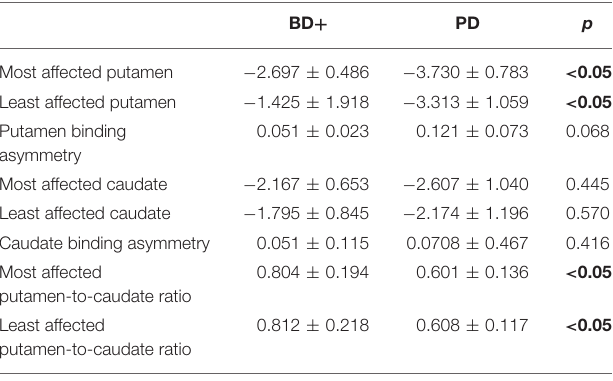
TABLE 3 | Comparisons of DaT binding values ( z scores) between BD patients with abnormal DaTSCAN (BD + ) and 12 age-matched PD patients (age = 72.25